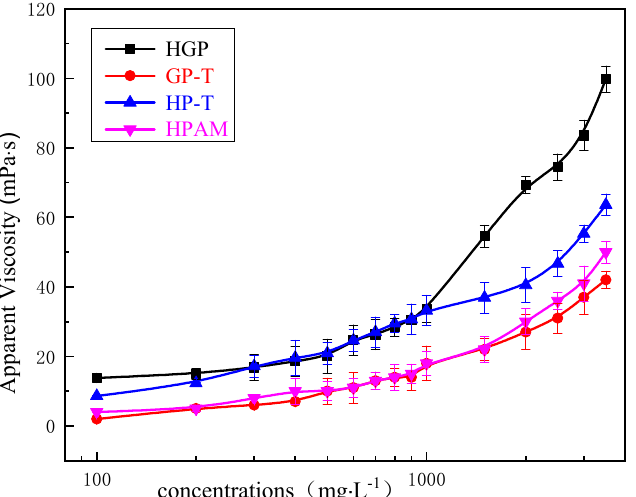
10 of 17 Figure 6. Conductivity changes in the dissolution process of copolymers at 25 °C. 3.5. Thickening Performance The viscosity of the polymer solution increases as the concentration increases. As shown in Figure 7, the four polymers exhibited good proportional linear thickening prop- erties. When the concentration increased from 1000 mg/L to 3500 mg/L, the growth rate in viscosity of the HGP was the highest (168%), and HP-T had the lowest liquid viscosity